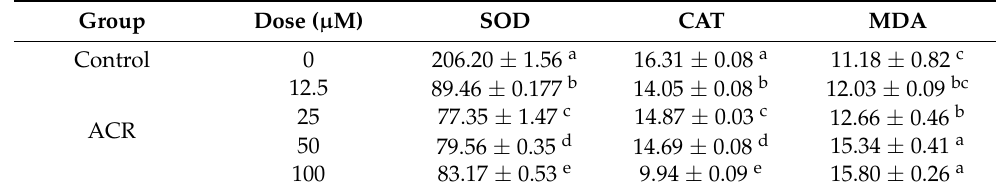
Values represent mean ± standard deviations. Significant differences ( p < 0.05) in the same column were expressed by using different letters ( a , bcd , and e ). SOD, U/mg prot; CAT, U/mg prot; MDA, nmoL/mg